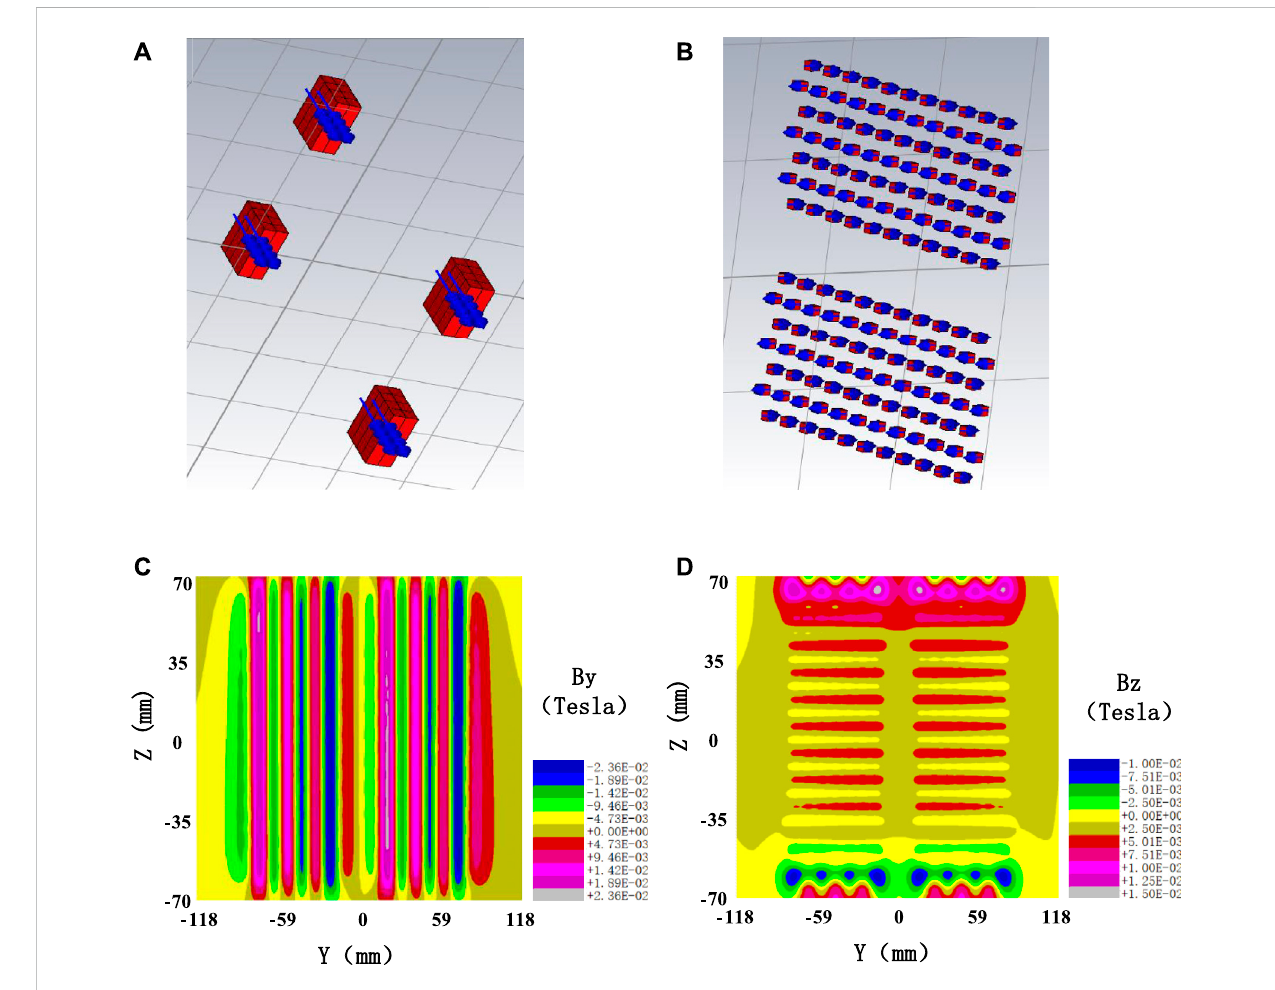
FIGURE 5 (A) The placement schematics of the fi lter magnets; (B) . The placement schematics of the de fl ection magnets; (C) . The magnetic fi eld component distribution of By on PG at X = 14 mm; (D) . The magnetic fi eld component distribution of Bz on PG at X = 14